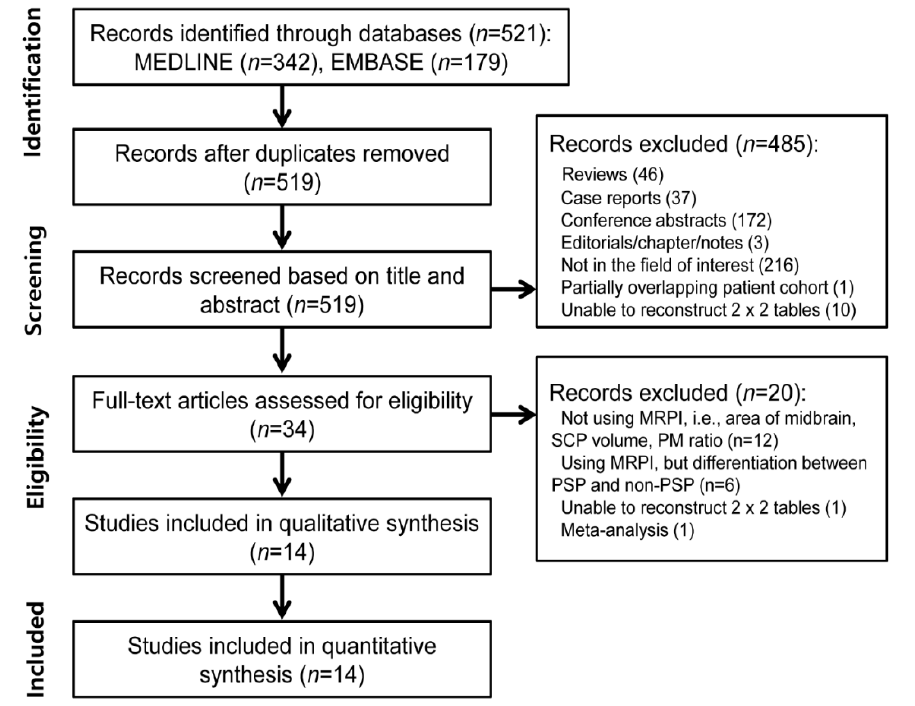
Figure 1. Flow diagram showing the study selection process for systematic review and meta- analysis. MRPI, magnetic resonance parkinsonism index; SCP, superior cerebellar peduncle; PM, pons-midbrain; PSP, progressive supranuclear palsy.